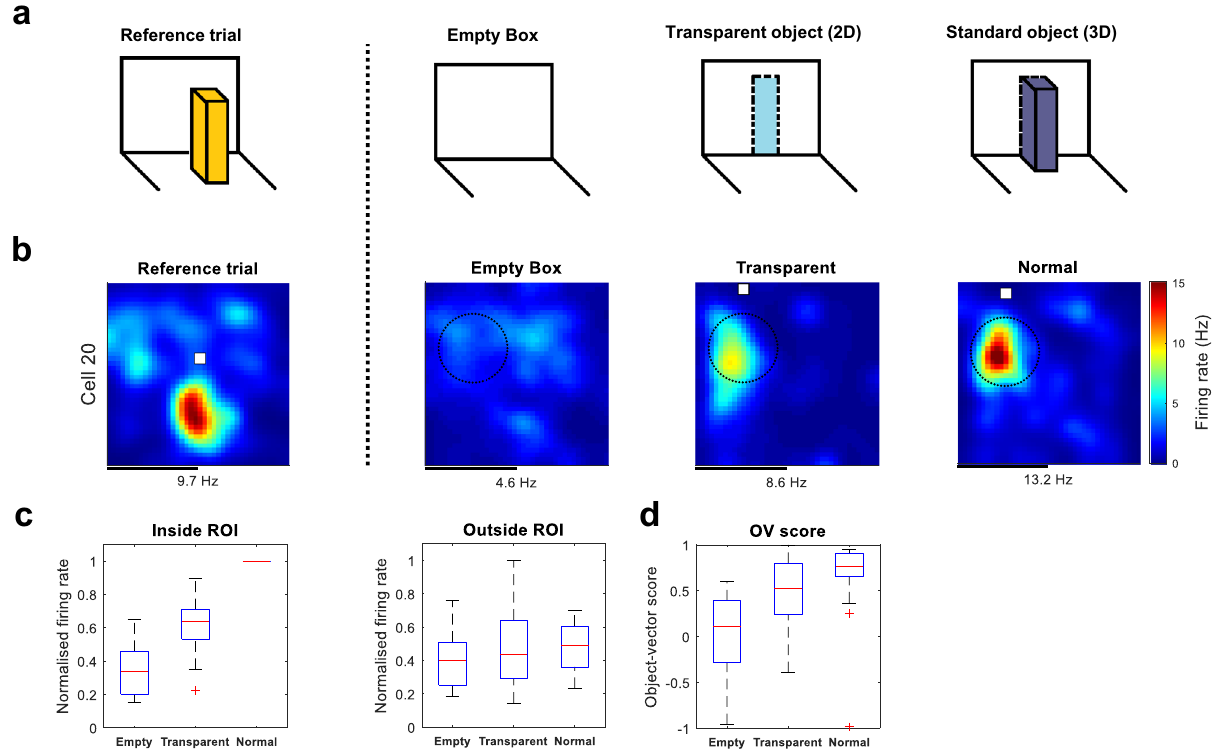
Fig. 3 Object-vector cells respond to transparent objects. a Experimental design with three different trials: either the box was empty, had a transparent object present, or a standard object present (a Duplo tower). The reference trial, used to fi nd the cell ’ s vector coordinates, is shown on the left. b Rate maps from example OV cell that responded strongly to the transparent object. Rate map conventions are as in Fig. 2. Scale bar, 40 cm. c Box-and-whisker plots of normalised fi ring rates (Hz) of OV cells ( n = 14) as a function of discreteness of the object, inside (left) or outside the ROI (right). d OV score as a function of object type. Conventions for box-and-whisker plots are as in Fig.